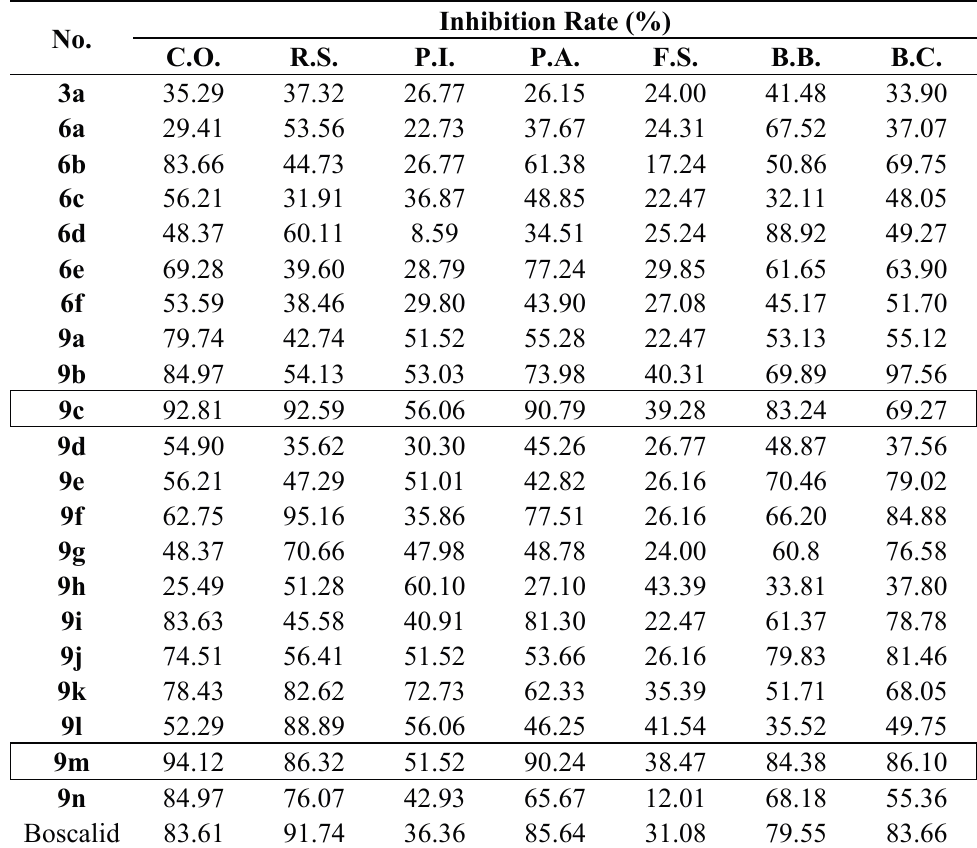
Table 1. In vitro antifungal activity of the target compounds against seven phyto-pathogenic fungi (50 μ g·mL − 1